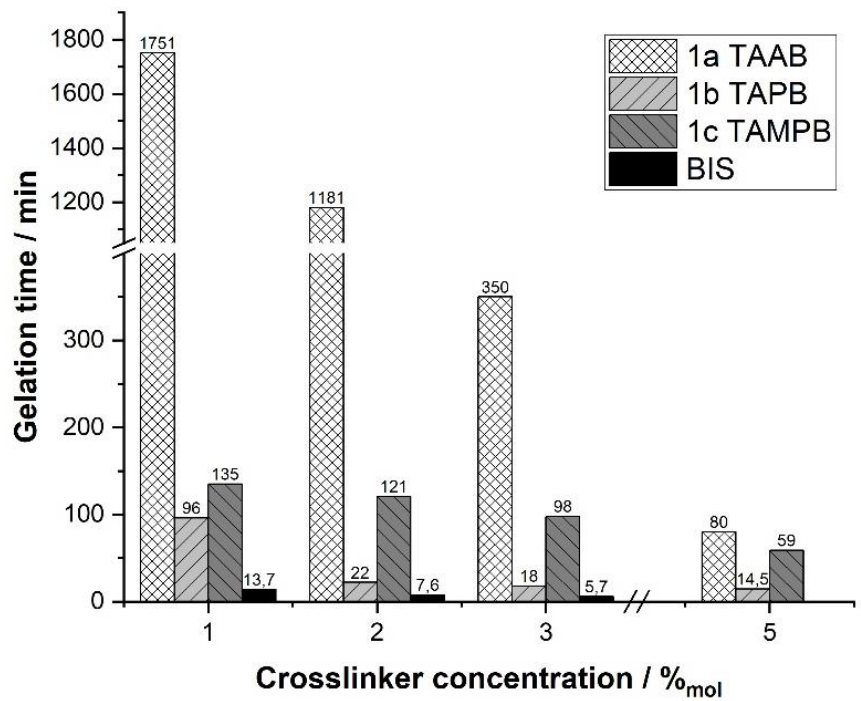
Figure 3. Gelation time of the cross-linking copolymerisation of DADMAC at 20 °C as a function of the cross-linker content. Reproducibility of the gel points is approx. ±10 %.